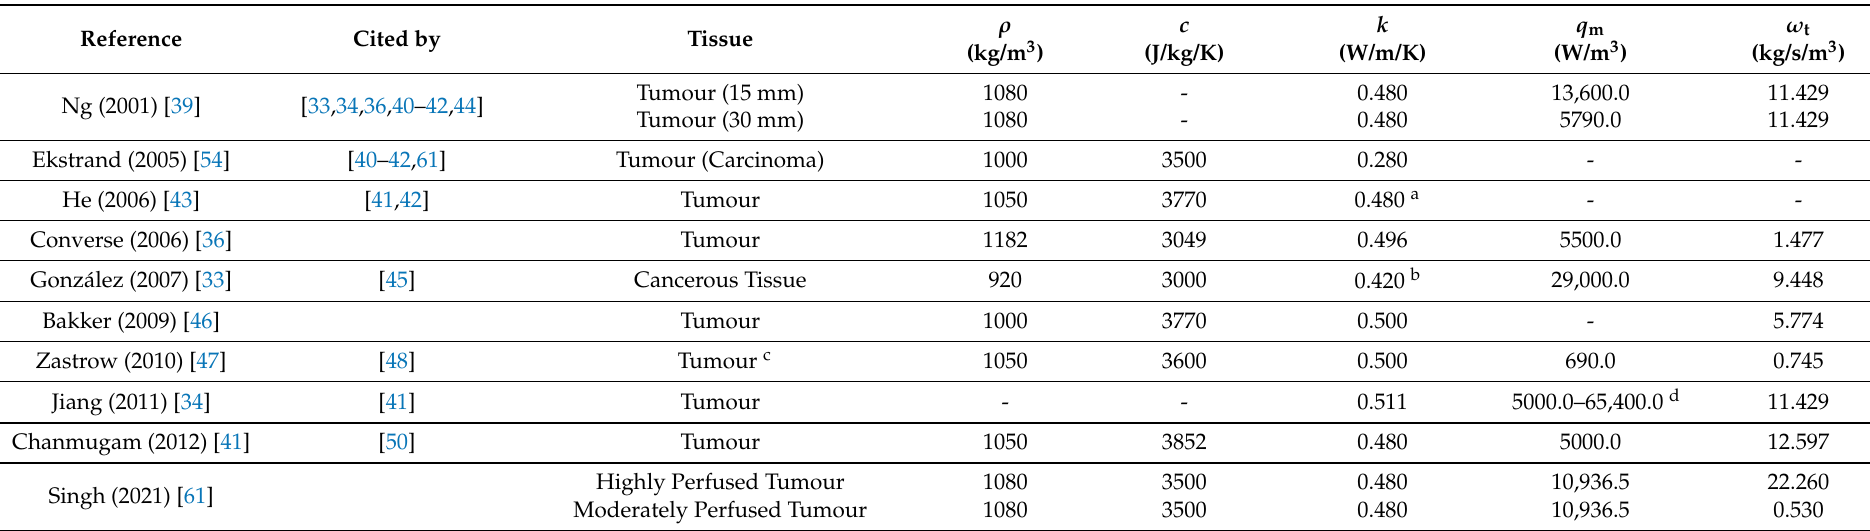
Table 6. Thermal and physiological properties of human breast tumours resulting from estimations, i.e., Non-Measured